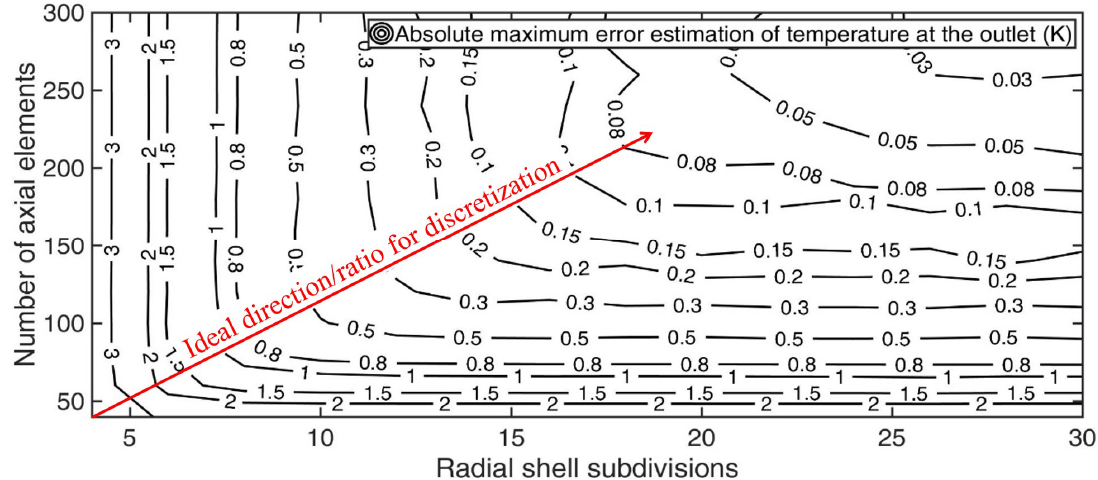
Figure 15. Relative maximum temperature error estimations of the outer surface (Case 2).